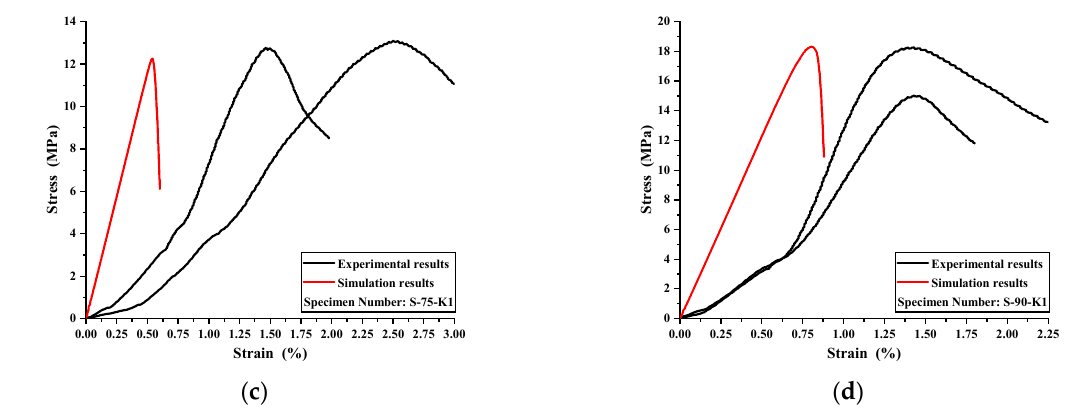
Figure 8. The experimental and simulated stress ‒ strain curves.